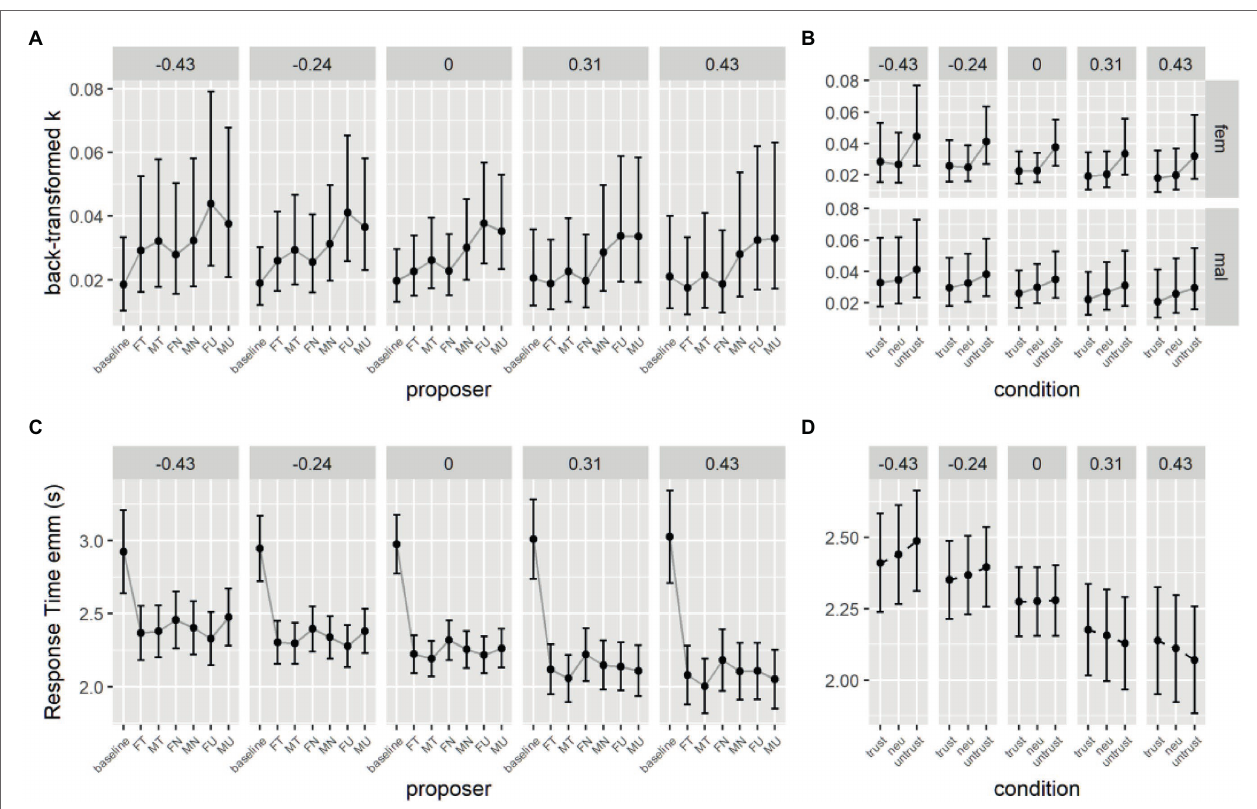
FIGURE 5 | (A) Parameter estimates from the first model and ( B) parameter estimates from the second model without the baseline after including emotion recognition ability. (C) Response times across conditions at various levels of emotion recognition ability. (D) Response times across proposers’ trustworthiness levels at various levels of emotion recognition ability.